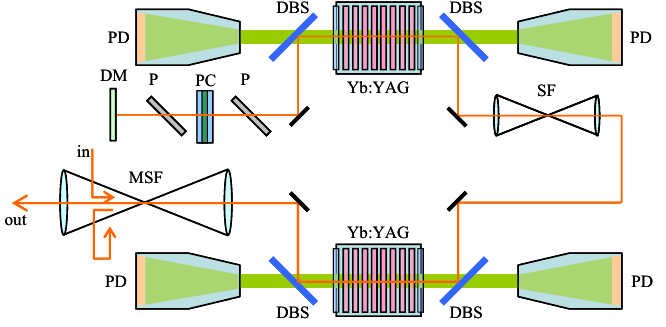
Figure 2. Optical layout of the 100J laser system with two amplifier heads. Shown are amplifiers heads with laser slabs (Yb:YAG), dichroic beam splitters (DBS), pumping modules (PD), spatial filters (SF), multipass spatial filter (MFS), polarizes (P), Pockels cell (PC), and deformable mirror